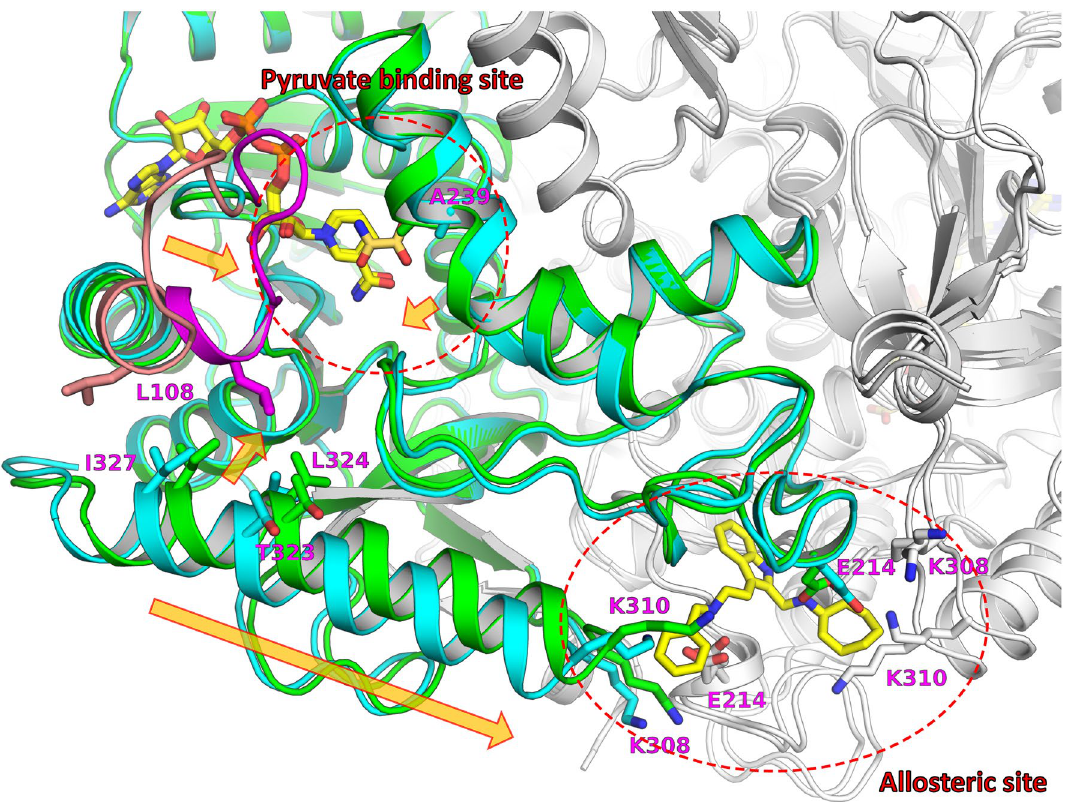
Figure 6. Superposition of the LDHB/NADH/oxamate/AXKO-0046 complex (green or magenta) with the LDHB/NADH complex (cyan or salmon). For clarity, one monomer of each tetramer is coloured, whereas others are in grey. NADH, oxamate, and AXKO-0046 are depicted as stick models in yellow, yellow-orange, and yellow, respectively. Key side chains of key residues are also depicted as stick models and labelled. The active site and allosteric site are highlighted in red dot circles. Structural rearrangements by substrate binding are indicated with orange